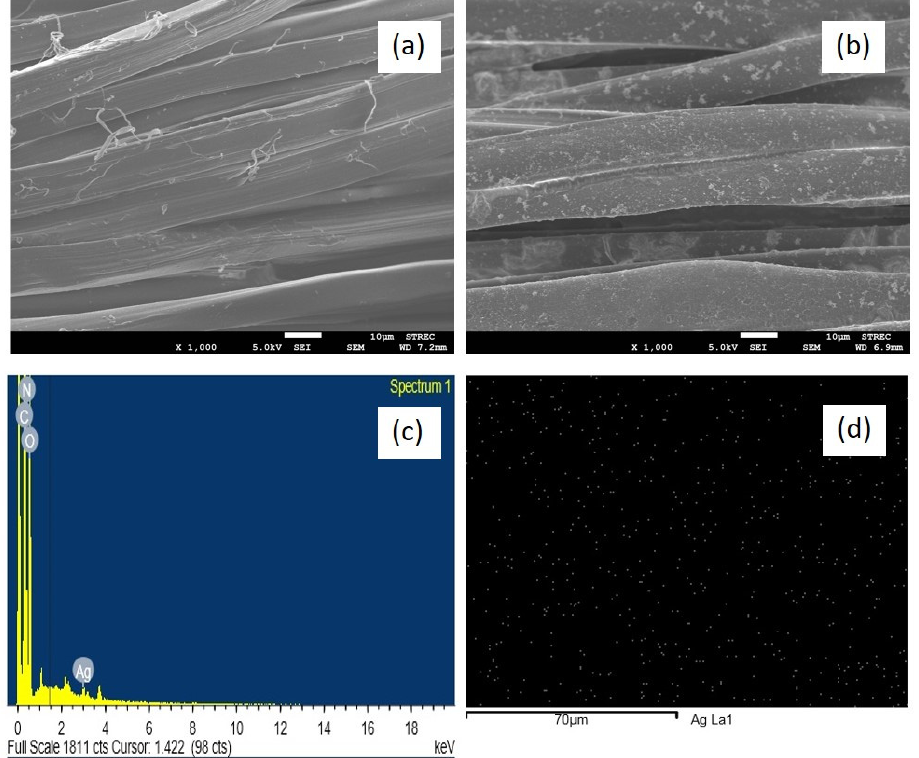
Figure 5. The Scanning Electron Microscope (SEM-EDX), images of SS-AgNP functionalized silk fabrics ( a ) untreated at 1000×; ( b ) treated at 1000×; ( c , d ) EDX pattern and AgNP distribution of treated fabrics.